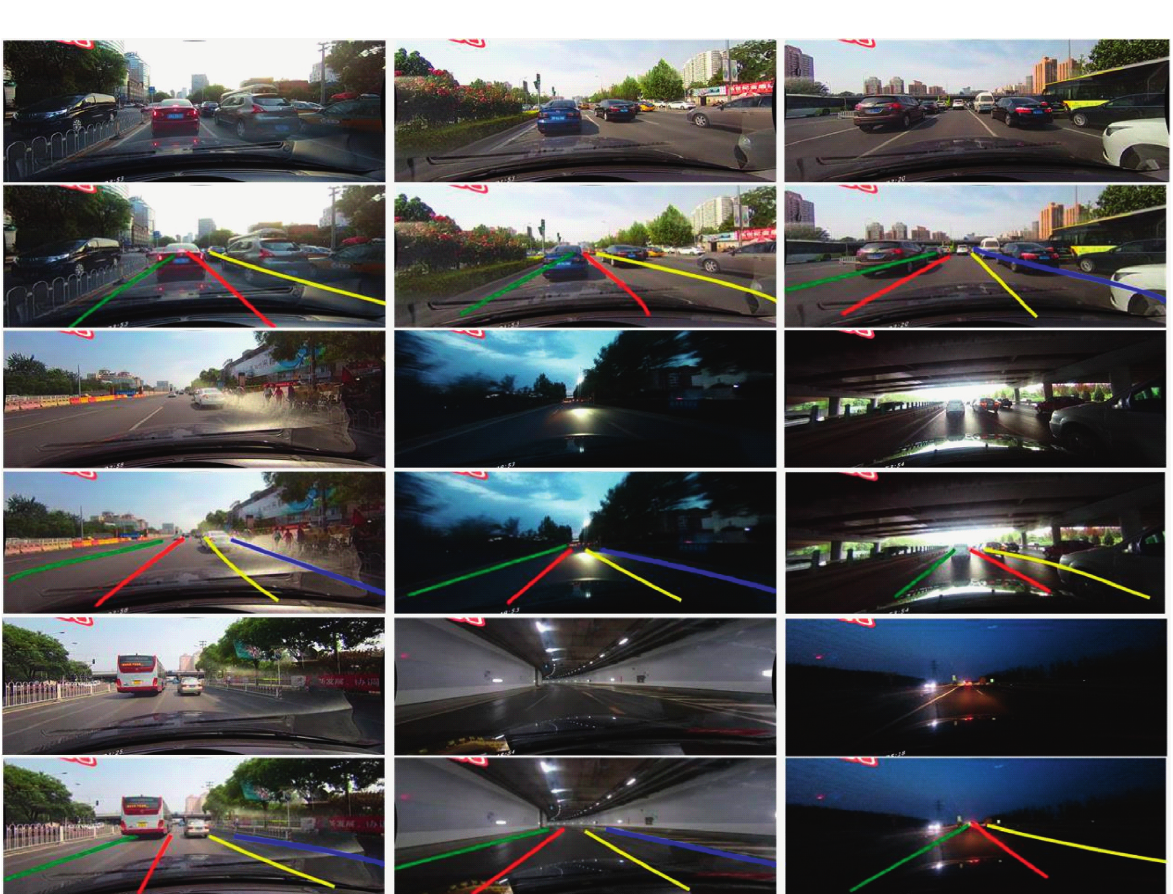
Figure 10: Robustness test for proposed method on CULane test dataset. The odd lines display the original images, and the even lines present lane predictions overlapping on original images.